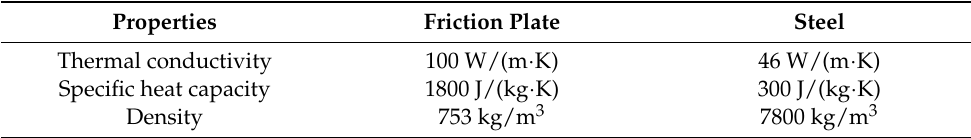
Table 2. The mechanical and thermal properties of friction plate and